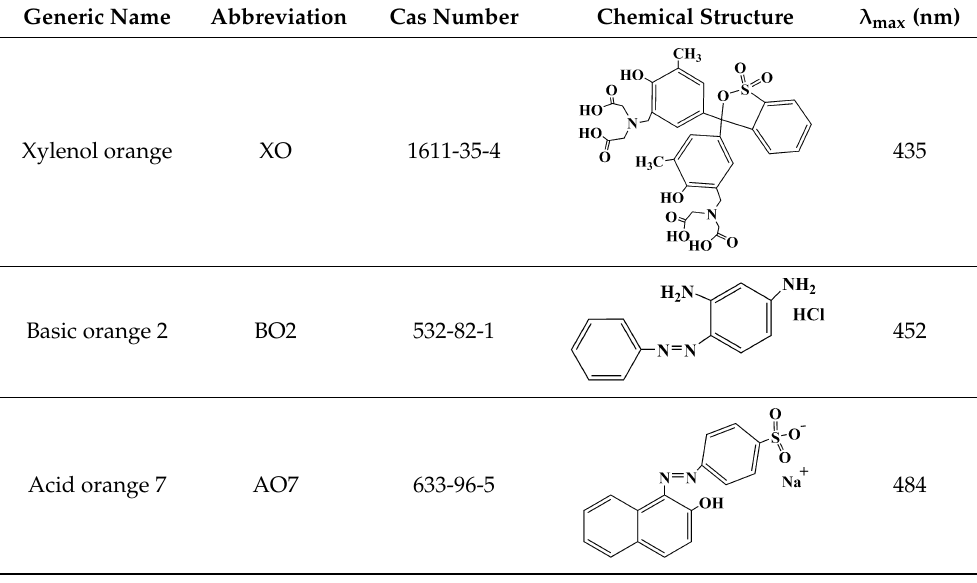
Table 1. General characteristics of AO7 dye.